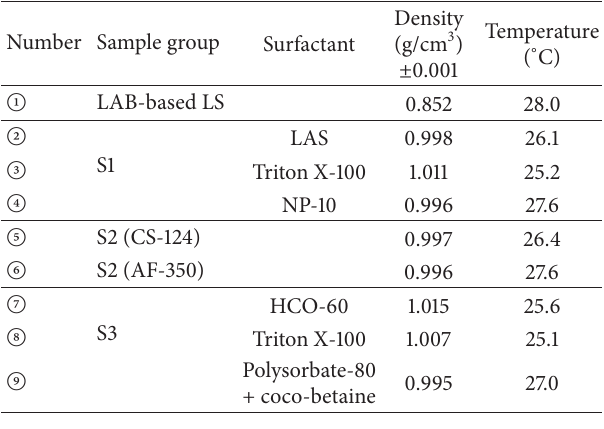
Table 3: Density of S1, S2, and S3 sample group. A LAB-based LS is added for a reference sample in the measurement of density comparison.